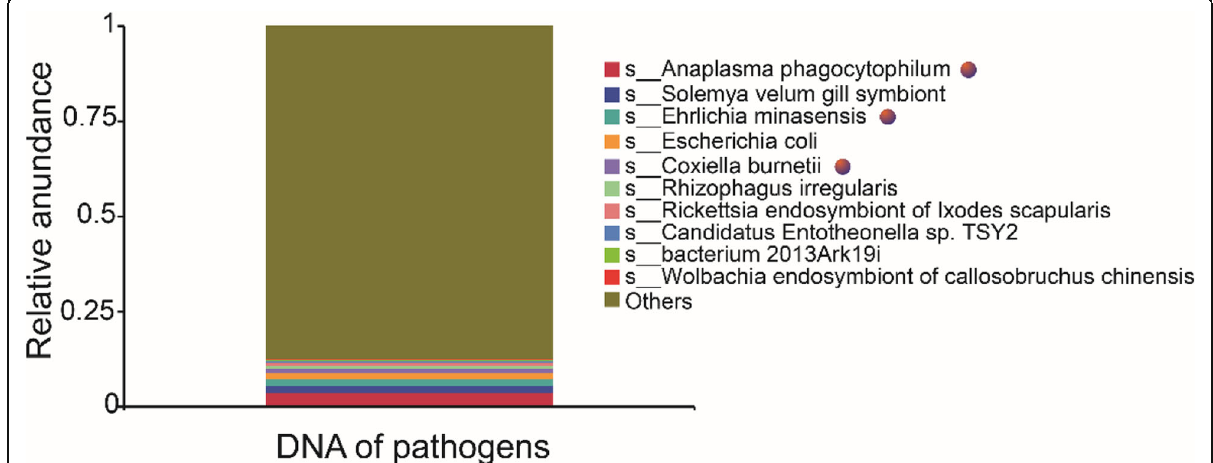
Fig. 4 The relative abundance of various bacterial species detected in the tick specimen. The red dots indicate pathogens that can infect humans